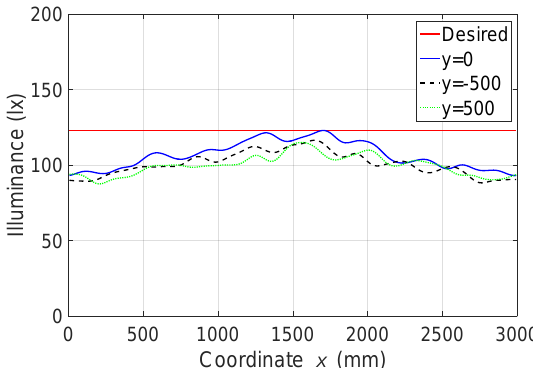
Figure 21. Illuminance distribution curves of two adjacent lighting points generated by the GA- optimized